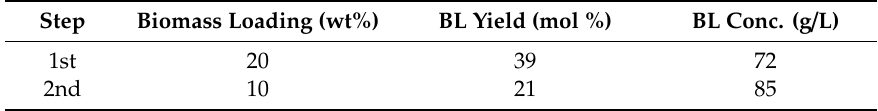
Table 3. Cross-flow butanolysis of ADW Eucalyptus nitens to BL. Reaction conditions: 190 ◦ C, 60 min, H 2 SO 4 1.2 wt% (added only at the 1st step), TR heating.